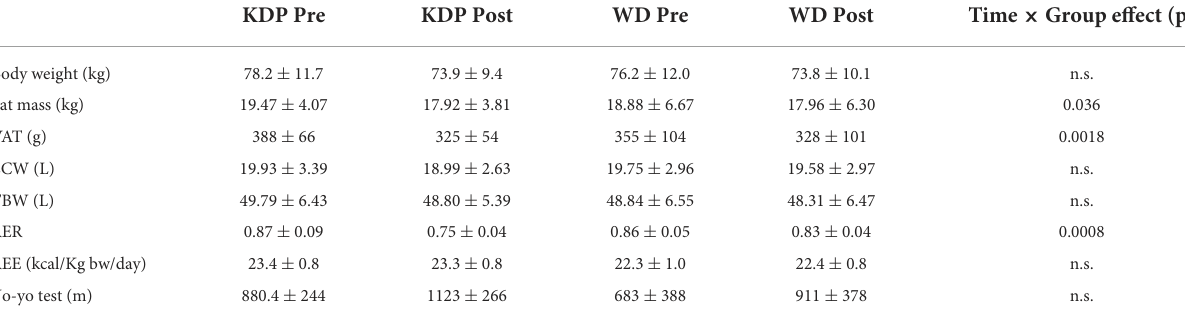
TABLE 3 Anthropometric and performance variables pre- and post-intervention [modified from Antonio Paoli et al.